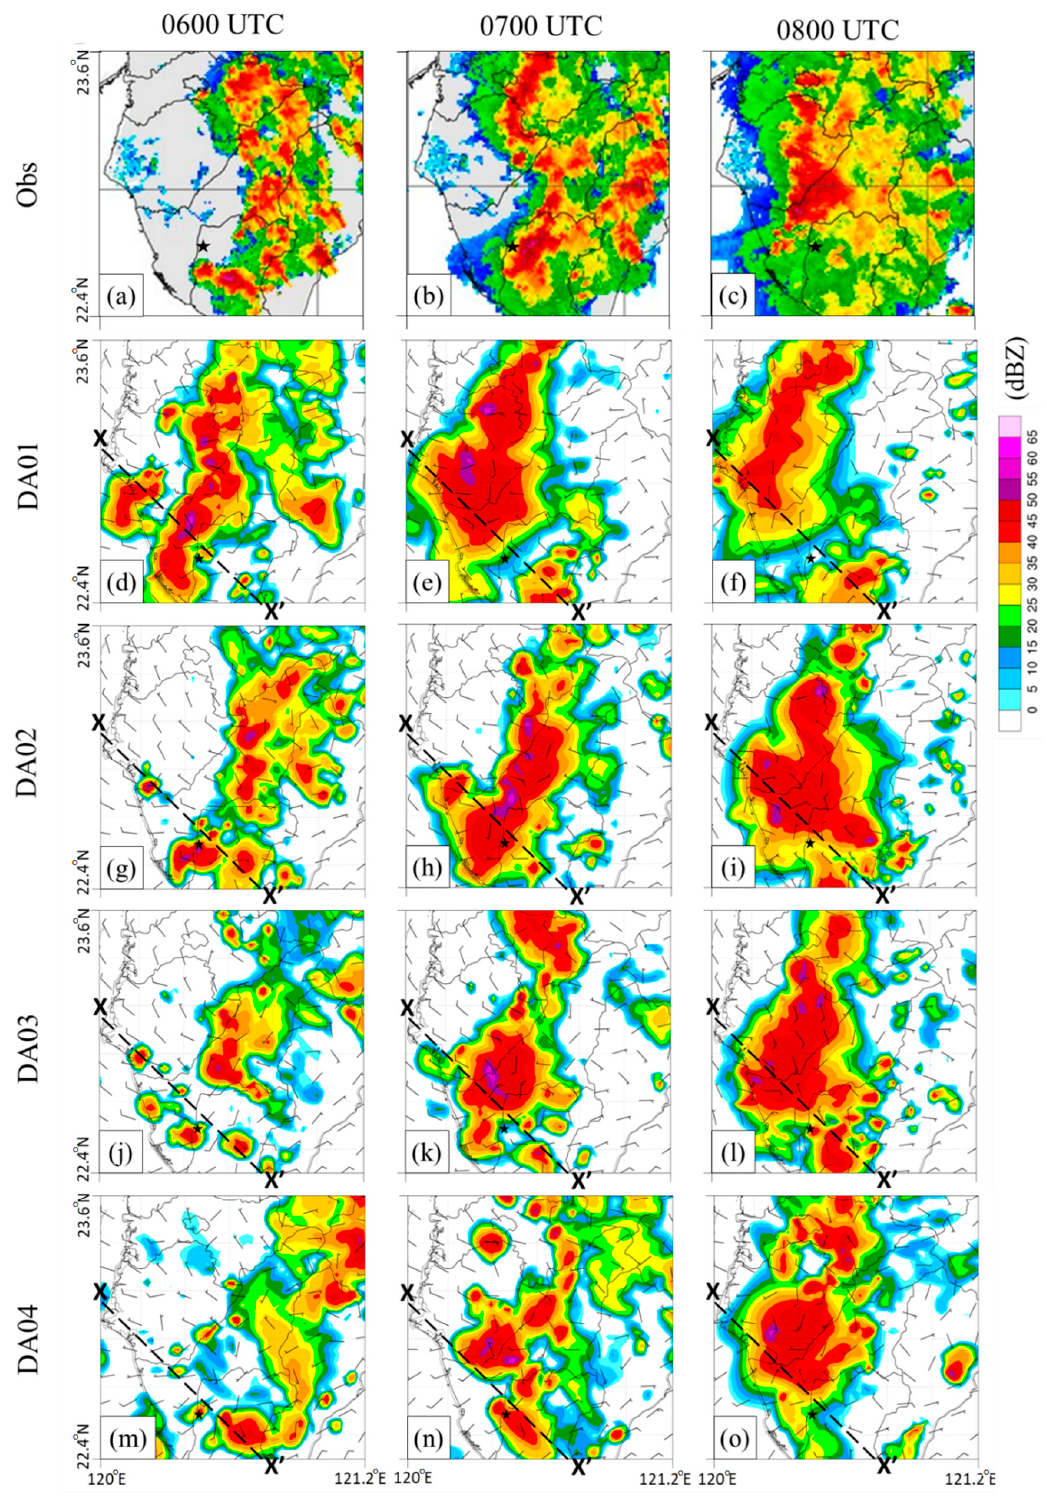
Figure 10. The observed and simulated 10-m wind (in arrow; intervals of 5 kt) and lowest model-level radar reflectivity (in color; dBZ) from 0600 to 0800 UTC (1400 to 1600 LST) on 5 August 2018, ( a – c ) observations, same as Figure 4, ( d – f ) DA01, ( g – i ) DA02, ( j – l ) DA03, and ( m – o ) DA04 simulations. Additionally shown are the approximate location of Pingtung Air Force Base (black star) and vertical cross-section planes (black line) for subsequent figures. Similar to Figure 9, the lines between x and x’ are plotted for further comparison.